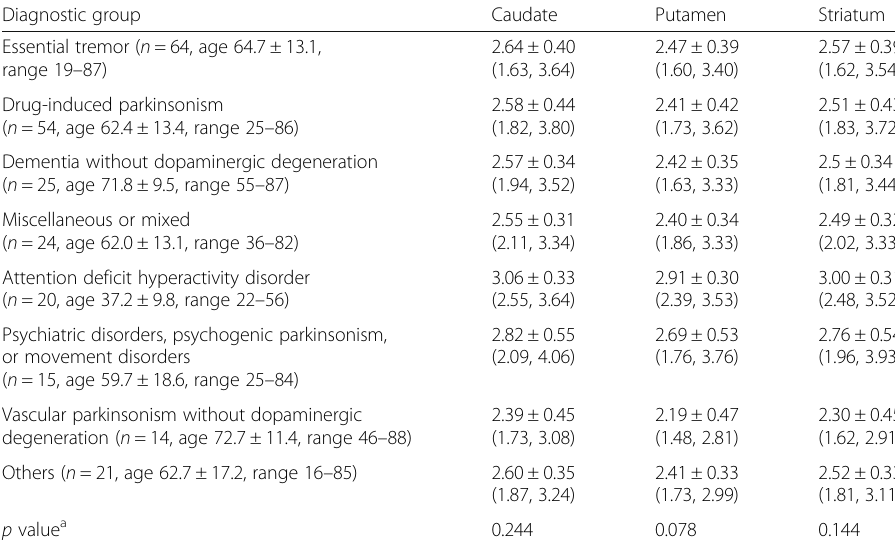
Table 3 Averaged left and right SBR values corresponding to different diagnostic groups